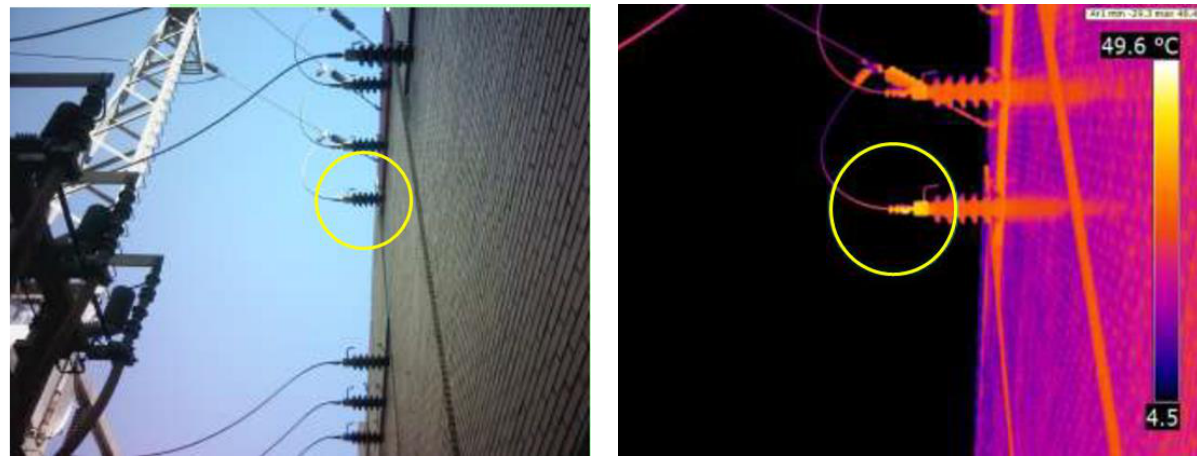
Figure 2. Visible and infrared images of a hot spot in a 66 kV wall bushing connector.